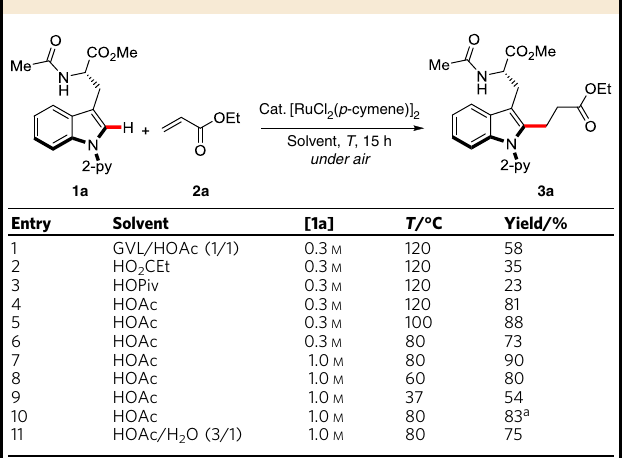
Table 1 Initial optimization of the C – H alkylation of tryptophan 1a